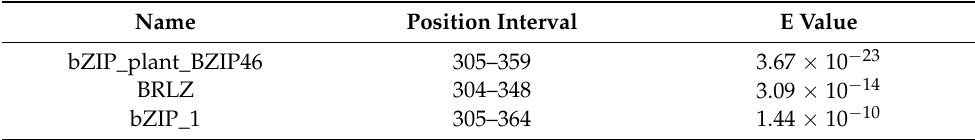
Figure 2. Domain structure of EsABI5 protein. Table 1. Domain prediction of EsABI5 -encoded